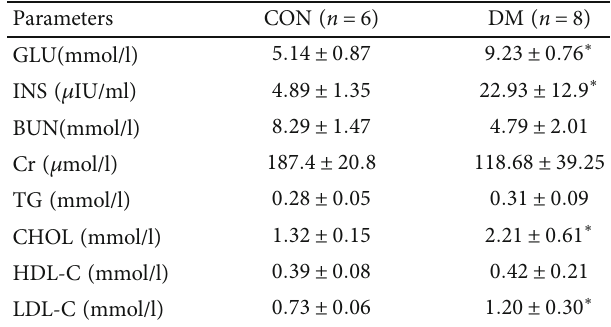
Table 1: Blood biochemical results in miniature swine diabetes